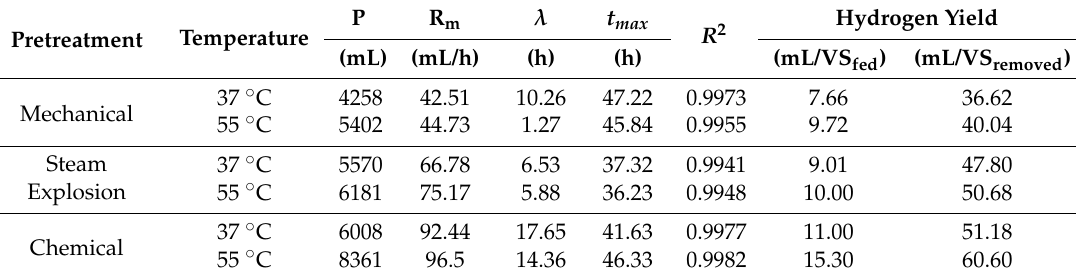
Table 2. Kinetic parameters and bio-hydrogen